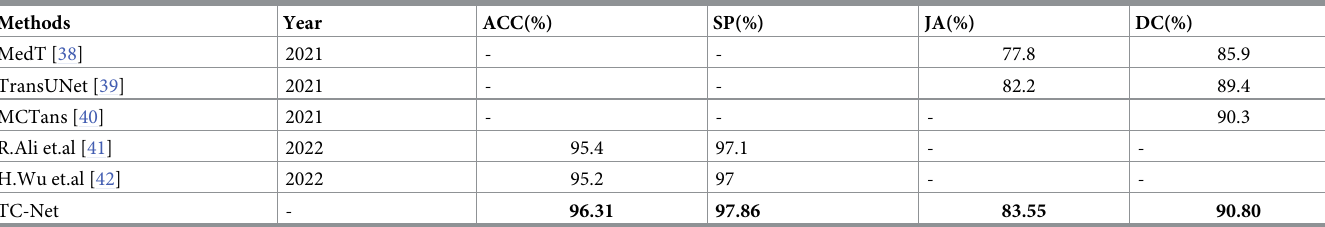
Table 7. Comparative experiences with state-of-the-art methods on fused networks. Methods